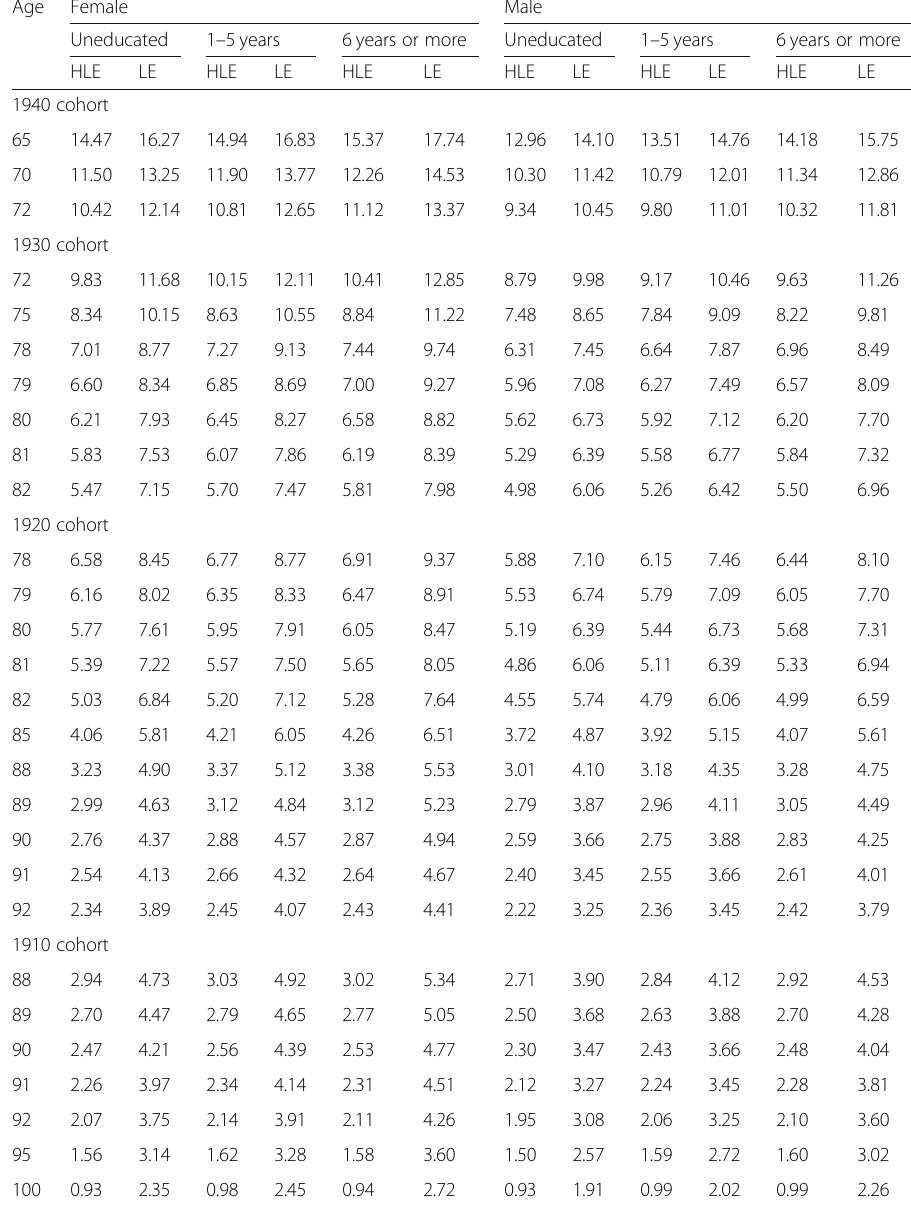
Table 5 The life expectancy and healthy life expectancy for different education backgrounds, in different cohorts, and at different